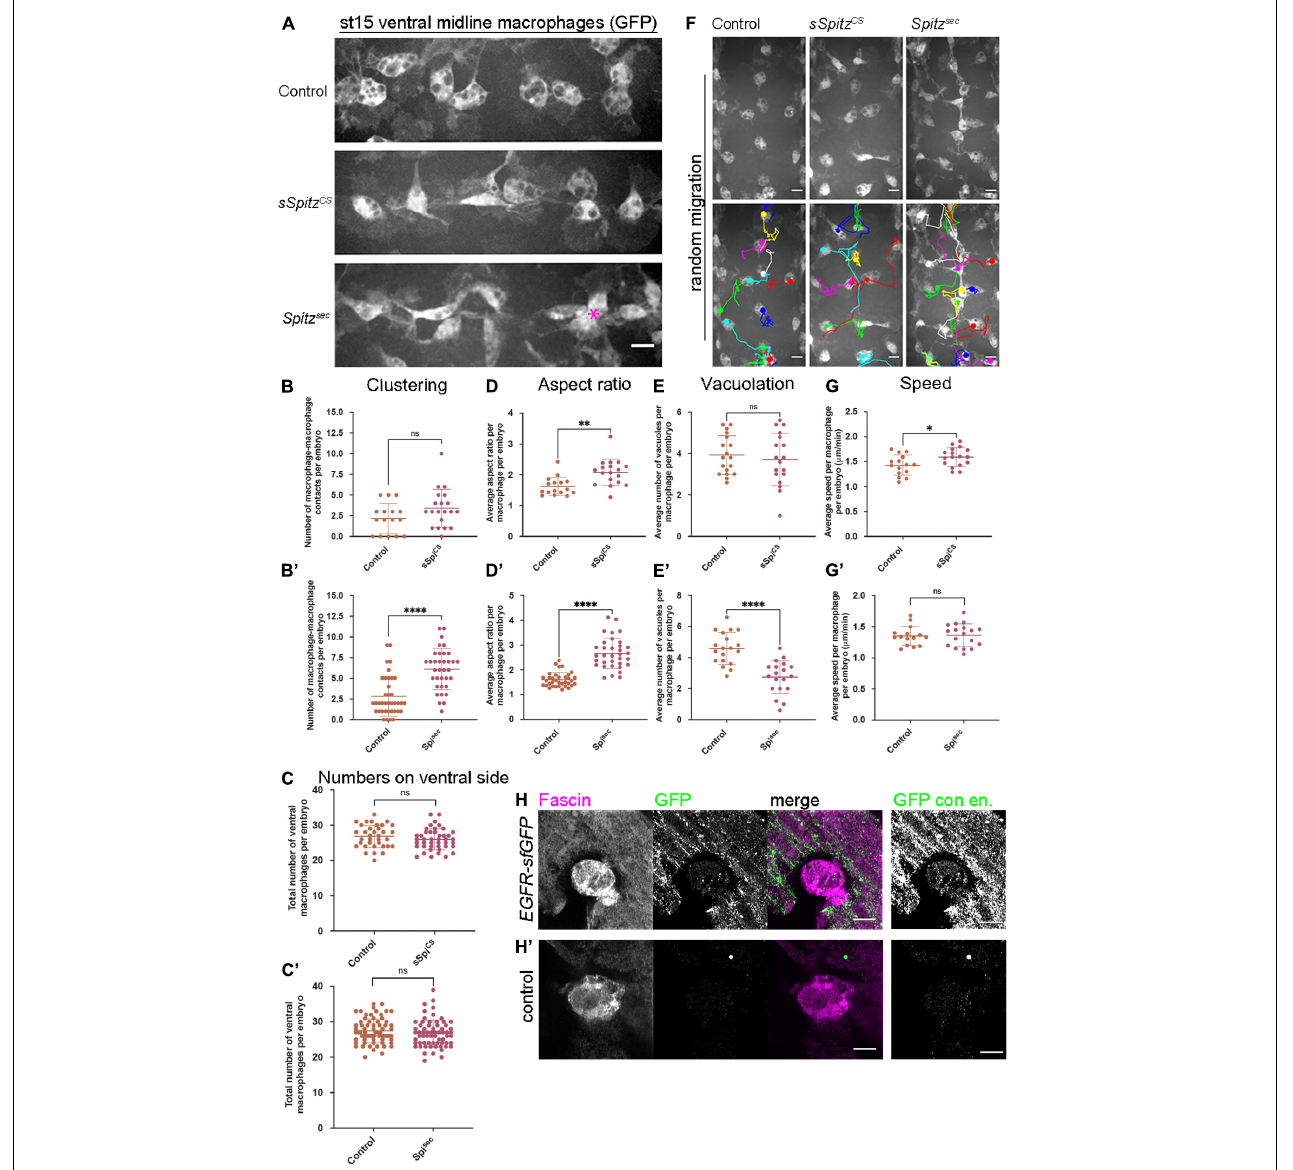
FIGURE 1 | Spitz stimulates macrophage polarization, impairs efferocytosis and alters migration dynamics. (A) Maximum projections of GFP-tagged macrophages on the ventral midline at stage 15 in control embryos and in embryos with macrophage-specific expression of sSpitz CS or Spitz sec ; asterisk ( ∗ ) shows cluster of macrophages on midline; anterior is left. (B,B (cid:48) ) Scattergraphs showing degree of macrophage clustering via number of macrophage-macrophage contacts per embryo in the presence of sSpitz CS (B) ( n = 16, 20; p = 0.0977) or Spitz sec (B (cid:48) ) ( n = 38, 35; p < 0.0001). (C,C (cid:48) ) Scattergraphs showing number of macrophages in the ventral midline region (VML) per embryo at stage 15 in the presence of sSpitz CS (C) ( n = 35, 43; p = 0.229) or Spitz Sec ( C (cid:48) ,D ) ( n = 73, 65; p = 0.247). (D,D (cid:48) ) Scattergraphs showing aspect ratio per macrophage per embryo in the presence of sSpitz CS (D) ( n = 16, 18; p = 0.0018) or Spitz Sec (D (cid:48) ) ( n = 35, 34; p < 0.0001). (E,E (cid:48) ) Scattergraphs showing average numbers of vacuoles per macrophage per embryo in controls in the presence of sSpitz CS (E) ( n = 18, 18; p = 0.574) or Spitz sec (E (cid:48) ) ( n = 19, 19; p < 0.0001). (F) Maximum projections and macrophage tracking data of GFP-labeled macrophages on the ventral midline at stage 15 in control embryos and in embryos with macrophage-specific expression of sSpitz CS or Spitz sec ; anterior is up. (G,G (cid:48) ) Scattergraphs of speed per macrophage per embryo over a 1-h period of random migration in controls and in the presence of sSpitz CS (G) ( n = 15, 17; p = 0.0229) or Spitz sec (G (cid:48) ) ( n = 15, 18; p = 0.858). (H,H (cid:48) ) Images of macrophages on the ventral midline at stage 15 in embryos containing GFP-tagged EGFR (EGFR-sfGFP) under the control of its endogenous promoter (H) and a control embryo lacking a modified EGFR locus (H (cid:48) ) . Embryos were immunostained for GFP (green in merge) and Fascin (magenta in merge) to reveal EGFR-sfGFP expression and identify macrophages, respectively; panels to the right of the merged images show contrast enhanced GFP channel. Scale bars denote 10 µ m (A,F) and 5 µ m (H,H (cid:48) ) ; lines and error bars represent mean and standard deviation on scattergraphs, respectively; significance bars denote ns p > 0.05, ∗ p < 0.05, ∗∗ p < 0.01, and ∗∗∗∗ p < 0.0001, respectively; statistical comparisons made via unpaired, two-tailed Student’s t -test (C,E,E (cid:48) ,G,G (cid:48) ) or Mann–Whitney test (B,B (cid:48) ,C (cid:48) ,D,D (cid:48) ) . Embryo genotypes are as follows: w; Srp-GAL4,UAS-GFP/ + ; Crq-GAL4,UAS-GFP/ +(Control), w; Srp-GAL4,UAS-GFP/UAS-sSpitz CS ; Crq-GAL4,UAS-GFP/ +(sSpi CS ), w; Srp-GAL4,UAS-GFP/ + ; Crq-GAL4,UAS-GFP/UAS-Spitz Sec (Spi sec ), w; EGFR-sfGFP (H) and w (H (cid:48) ) .